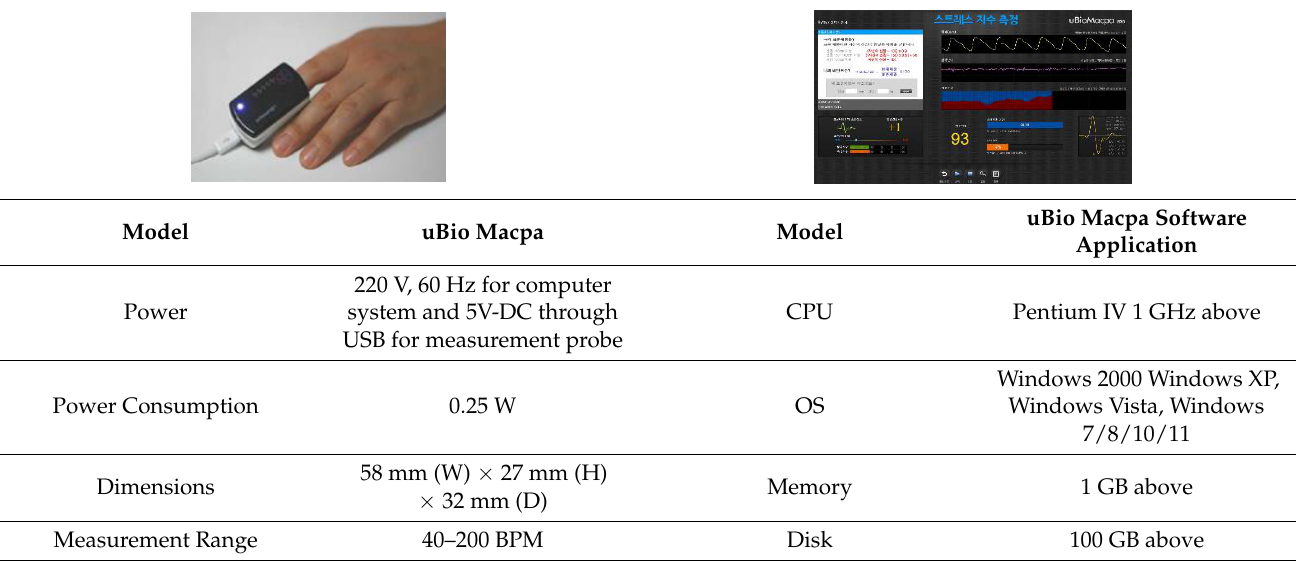
Table 3. Measurement device specifications and software application for HRV.